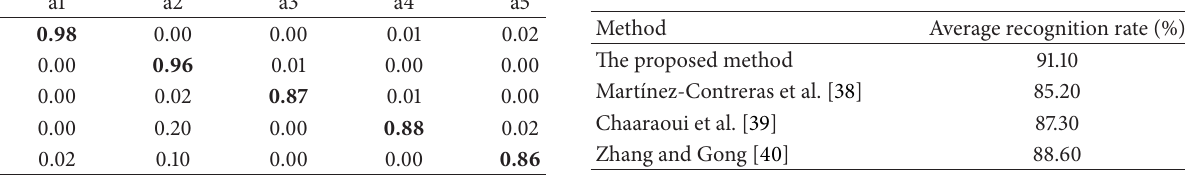
Table 7: Comparison with other approaches on UCF sportsaction dataset.